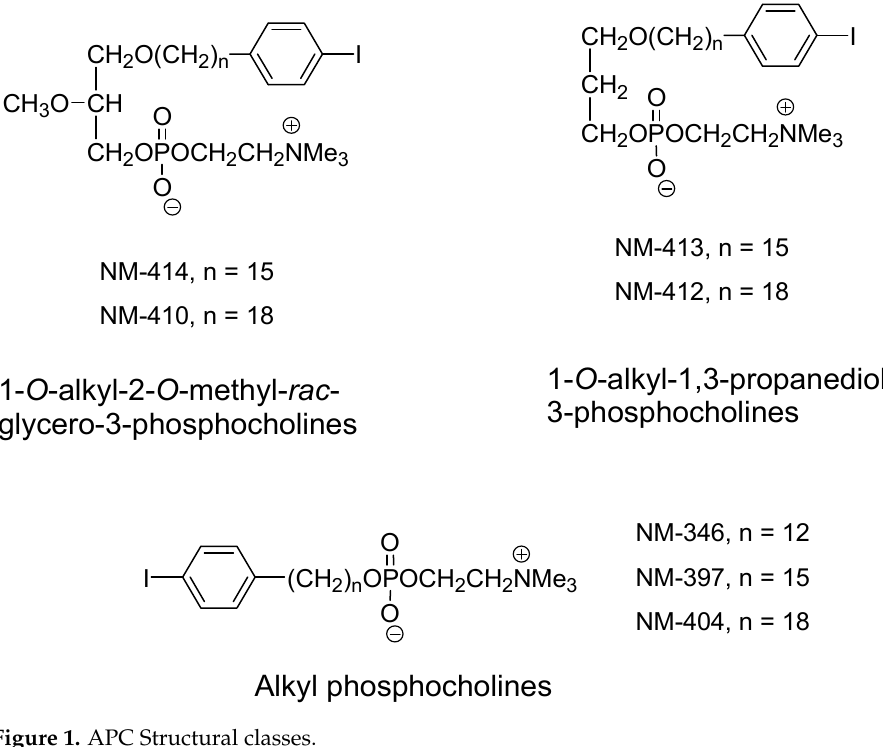
Figure 1. APC Structural